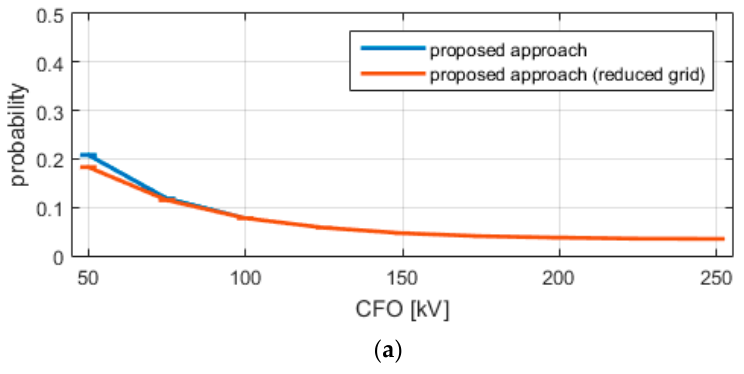
Figure 6. Cont. Figure 6.